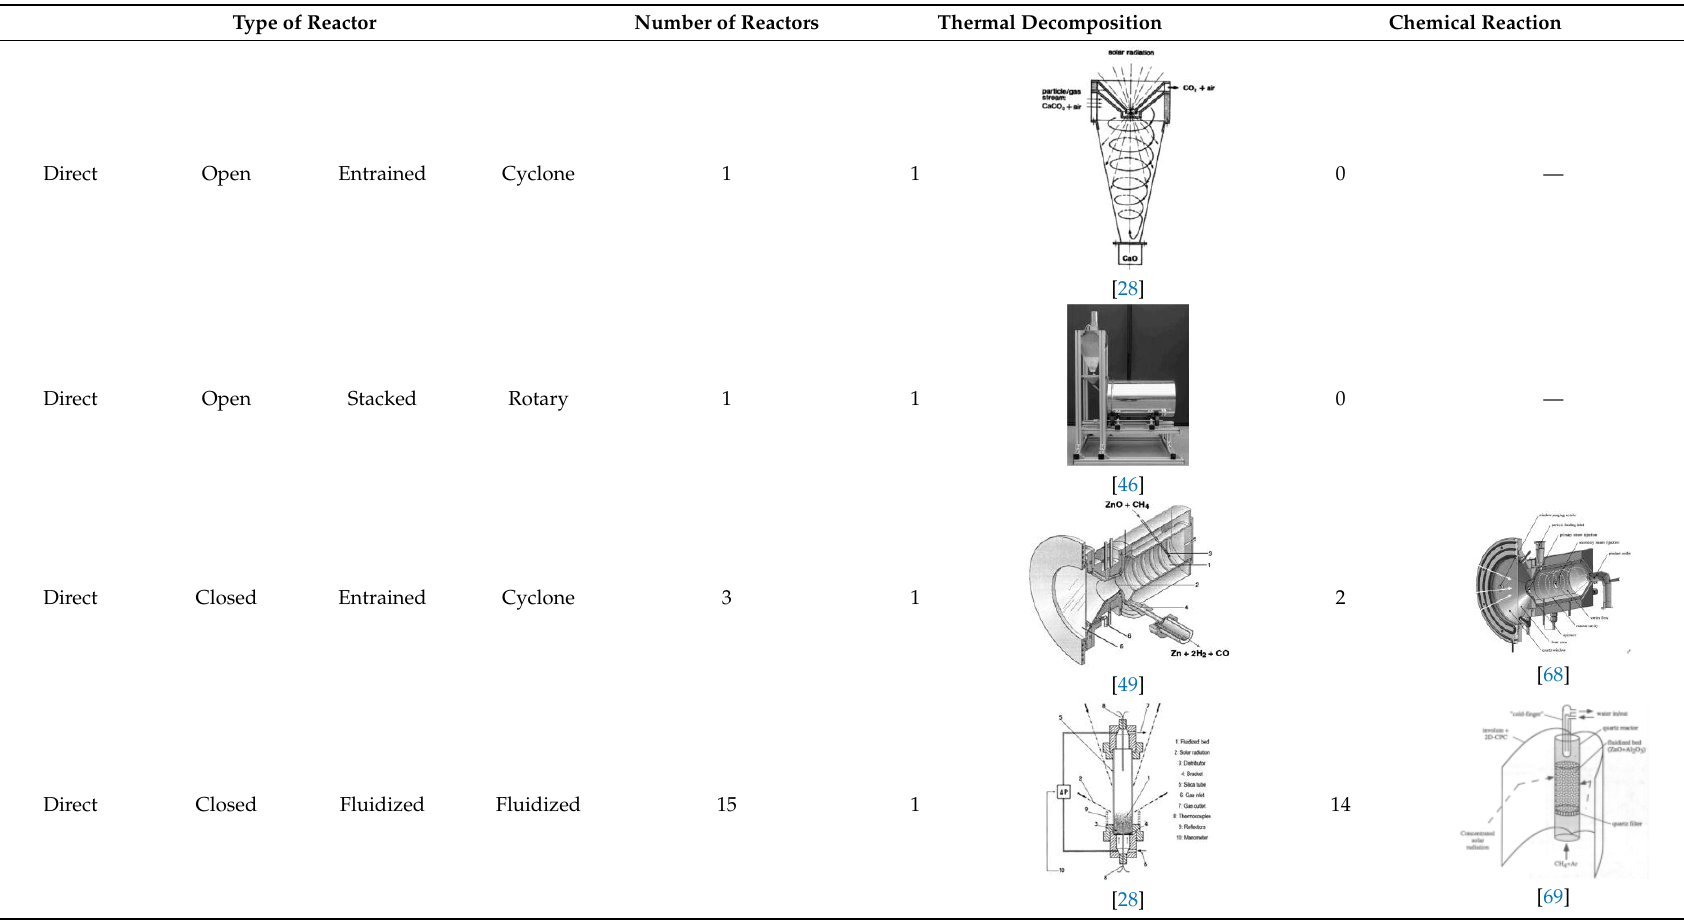
Table 3. Statistics of systems, reactors, and processes undergone.